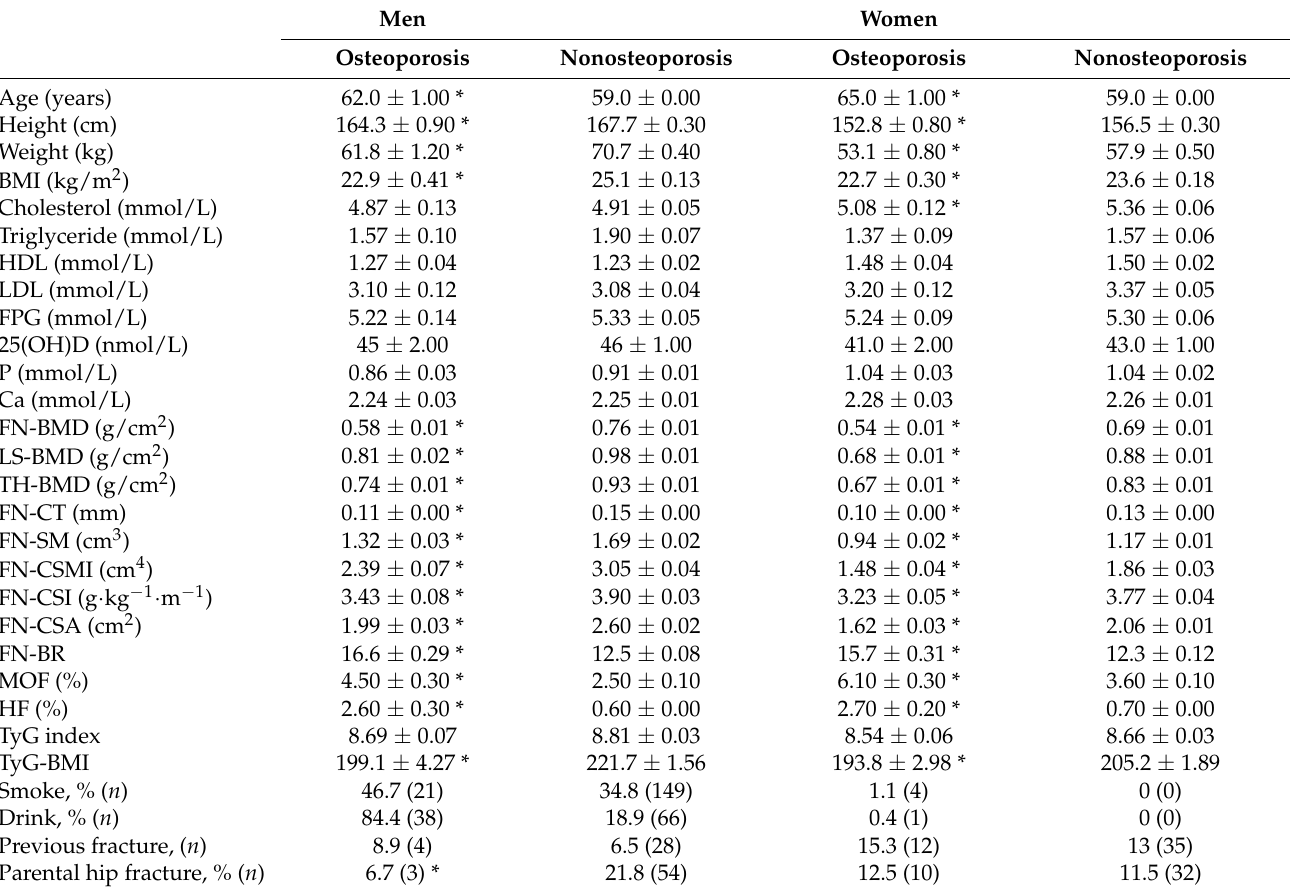
Table 1. Baseline characteristics of osteoporosis and nonosteoporosis